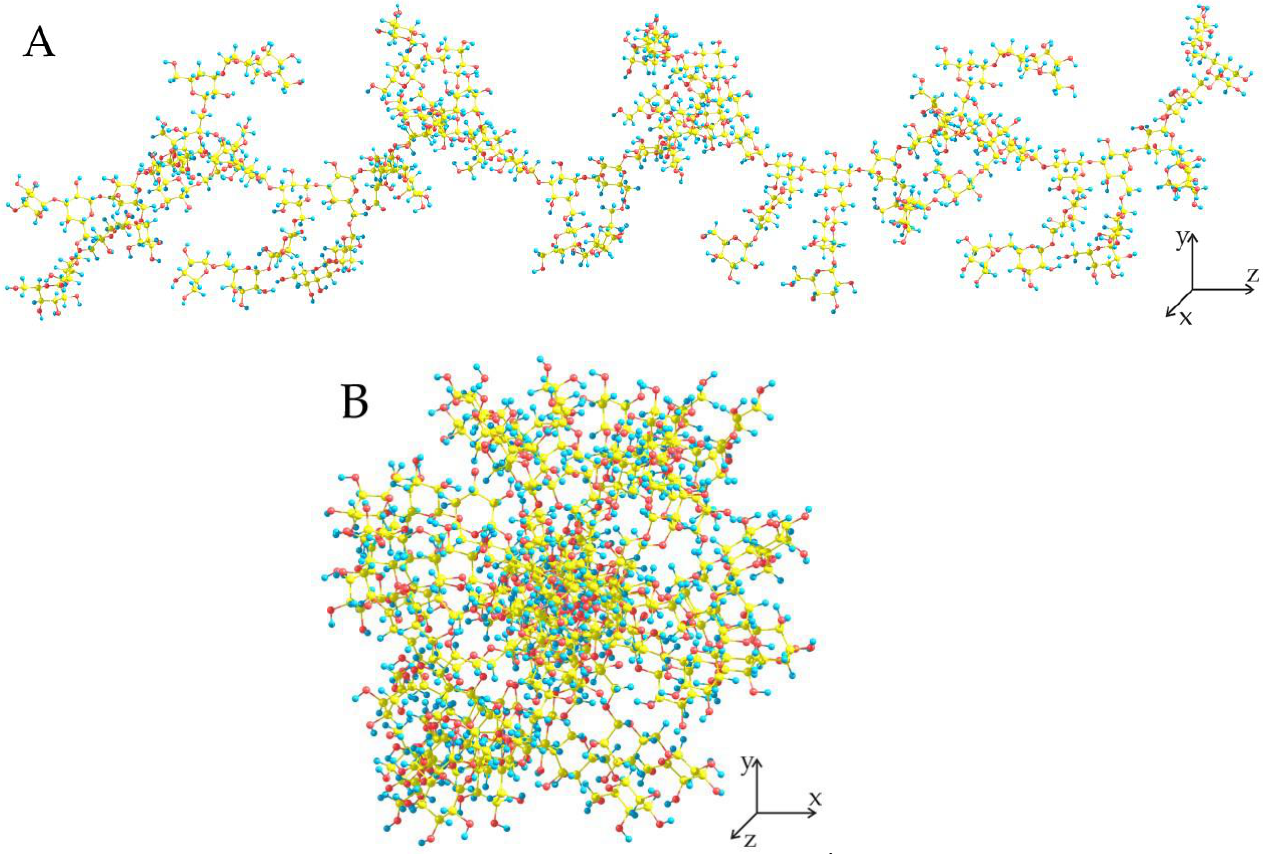
Figure 8. Structure of the arabinogalactan single molecule: ( A )—X-axis view, ( B )—Z-axis view.